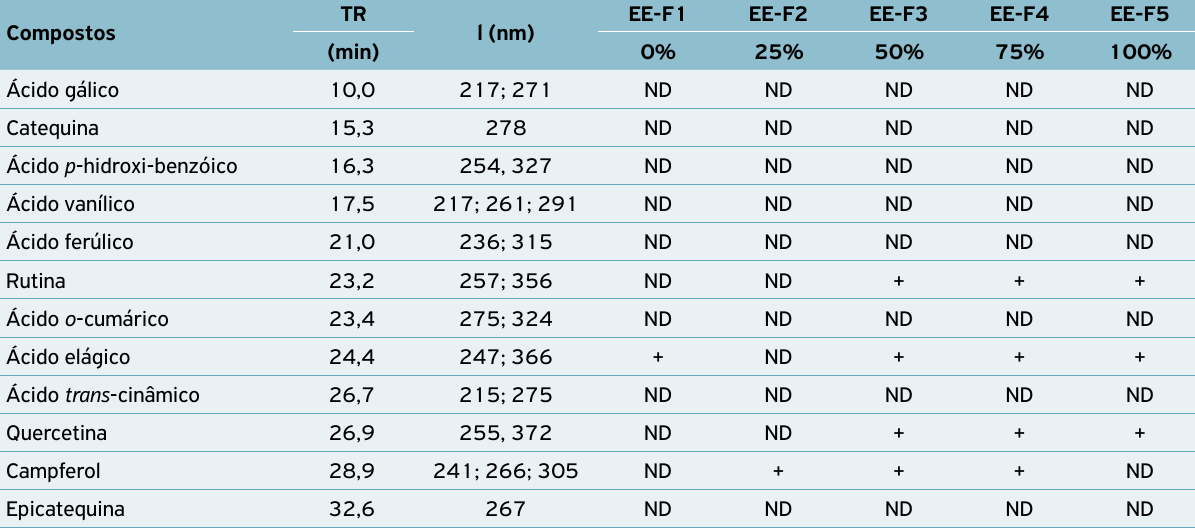
Tabela 2. Composição química das frações derivadas do extrato etanólico das folhas de A. zerumbet baseada no tempo de retenção e nas absorções máximas nos espectros de ultravioleta determinados por cromatografia líquida de alta eficiência acoplada a um detector de arranjo de diodo.